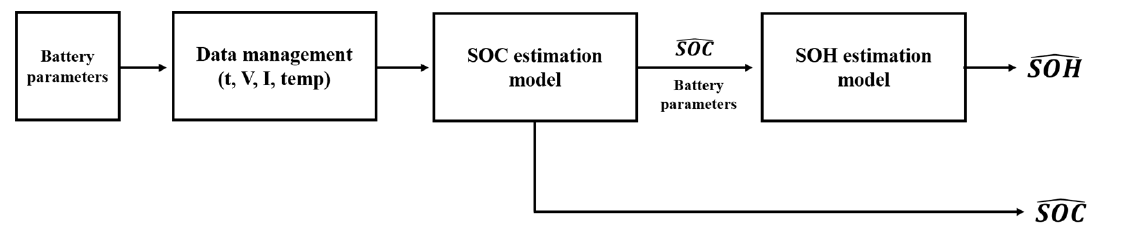
Figure 4. Process of proposed SOC and SOH estimation without a neural network model bank.